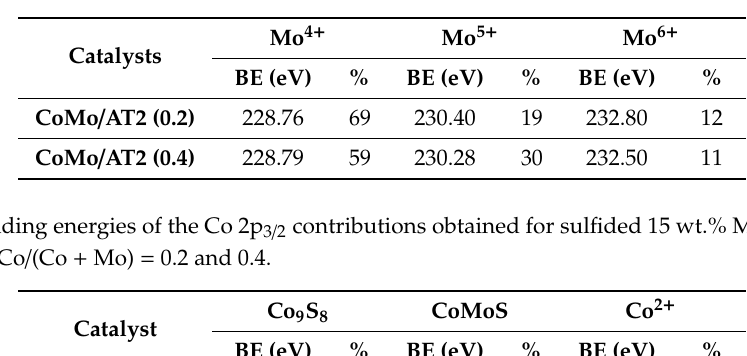
Table 4. Binding energies of the Mo 3d 5 / 2 contributions obtained for sulfided 15 wt.% Mo CoMo / AT2 catalysts at Co / (Co + Mo) = 0.2 and 0.4.